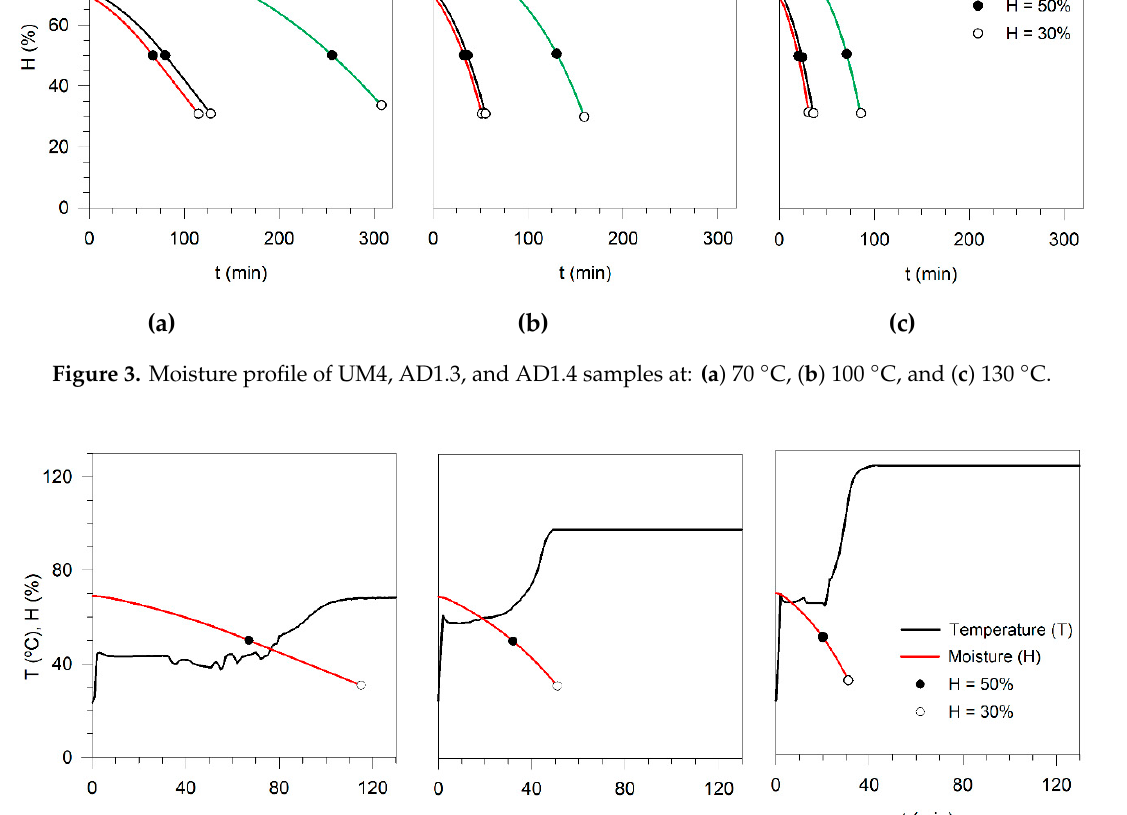
Figure 3. Moisture profile of UM4, AD1.3, and AD1.4 samples at: (a ) 70 °C, ( b ) 100 °C, and ( c ) 130 °C.